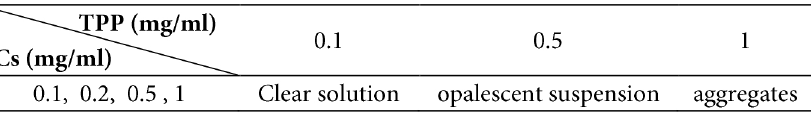
Table 1. Optimization of Cs: TPP concentrations for the formation of CS-NPs.